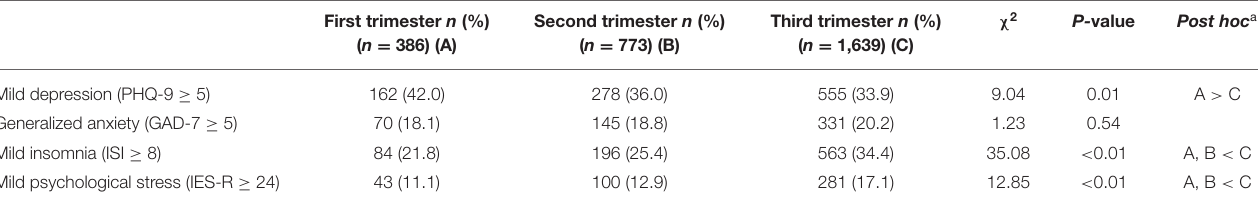
TABLE 4 | The occurrence of mild forms of depression, generalized anxiety, insomnia and psychological stress during the COVID-19 pandemic among pregnancy